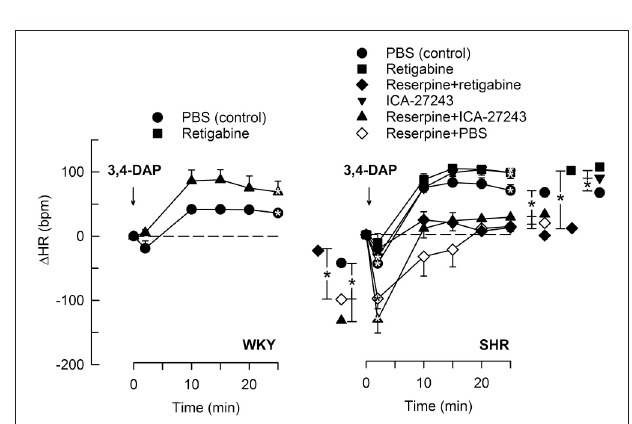
FIGURE 4 | The HR-response to 3,4-DAP after pre-treatment with Kv7-openers. Retigabine (K V 7.2-7.5) and ICA-27243 (K V 7.2-7.3) were administered alone or after reserpine, as indicated by symbol legends. Significant responses (* within symbol) and group differences (* in brackets) at about 1 (recorded at the TPR-peak-response) and at 25 min were located as indicated. Comparisons were made between corresponding control and experimental groups, and between groups pre-treated with retigabine/ICA-27243 alone and reserpine + retigabine/ICA-27243. * P < 0.025 after curve